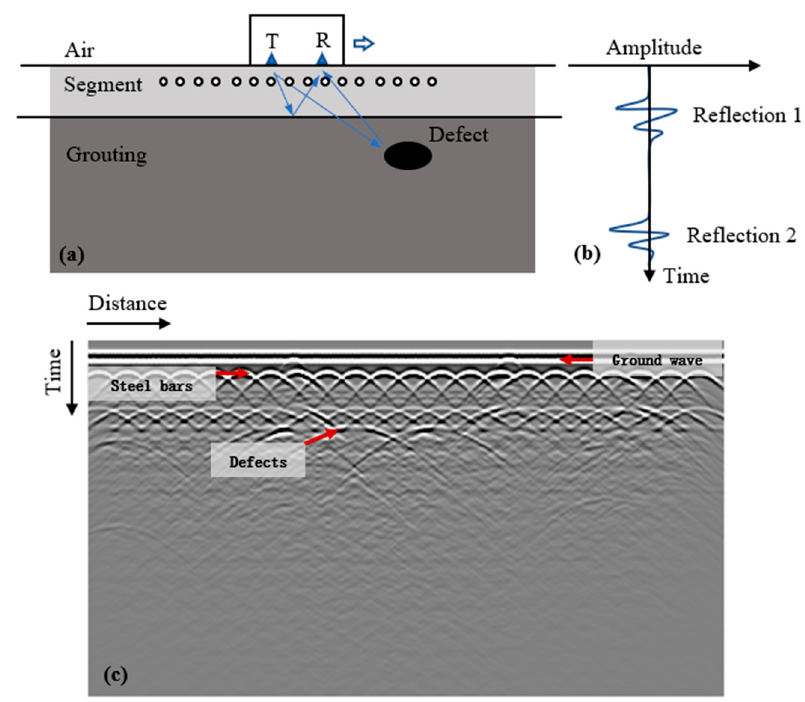
Figure 2. ( a ) Conceptual illustration of GPR use in defect detection by using a ground-coupled antenna system; ( b ) A-scan amplitude; ( c ) A synthetic B-scan profile for segment inspection.